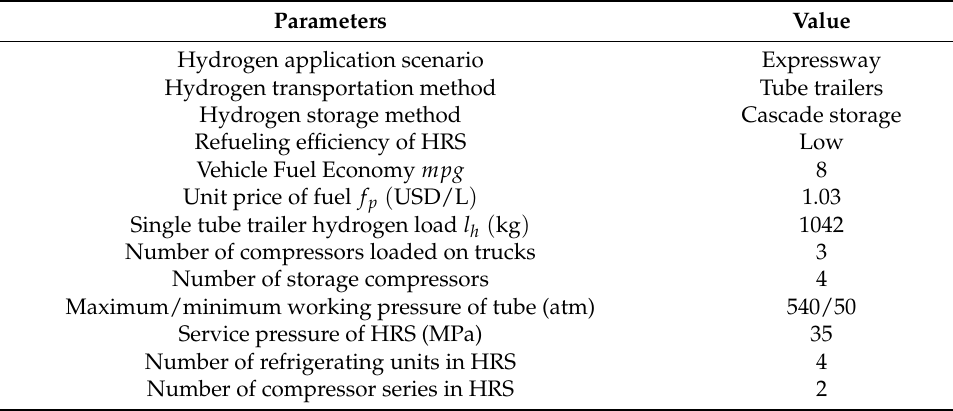
Table 8. Key parameters and